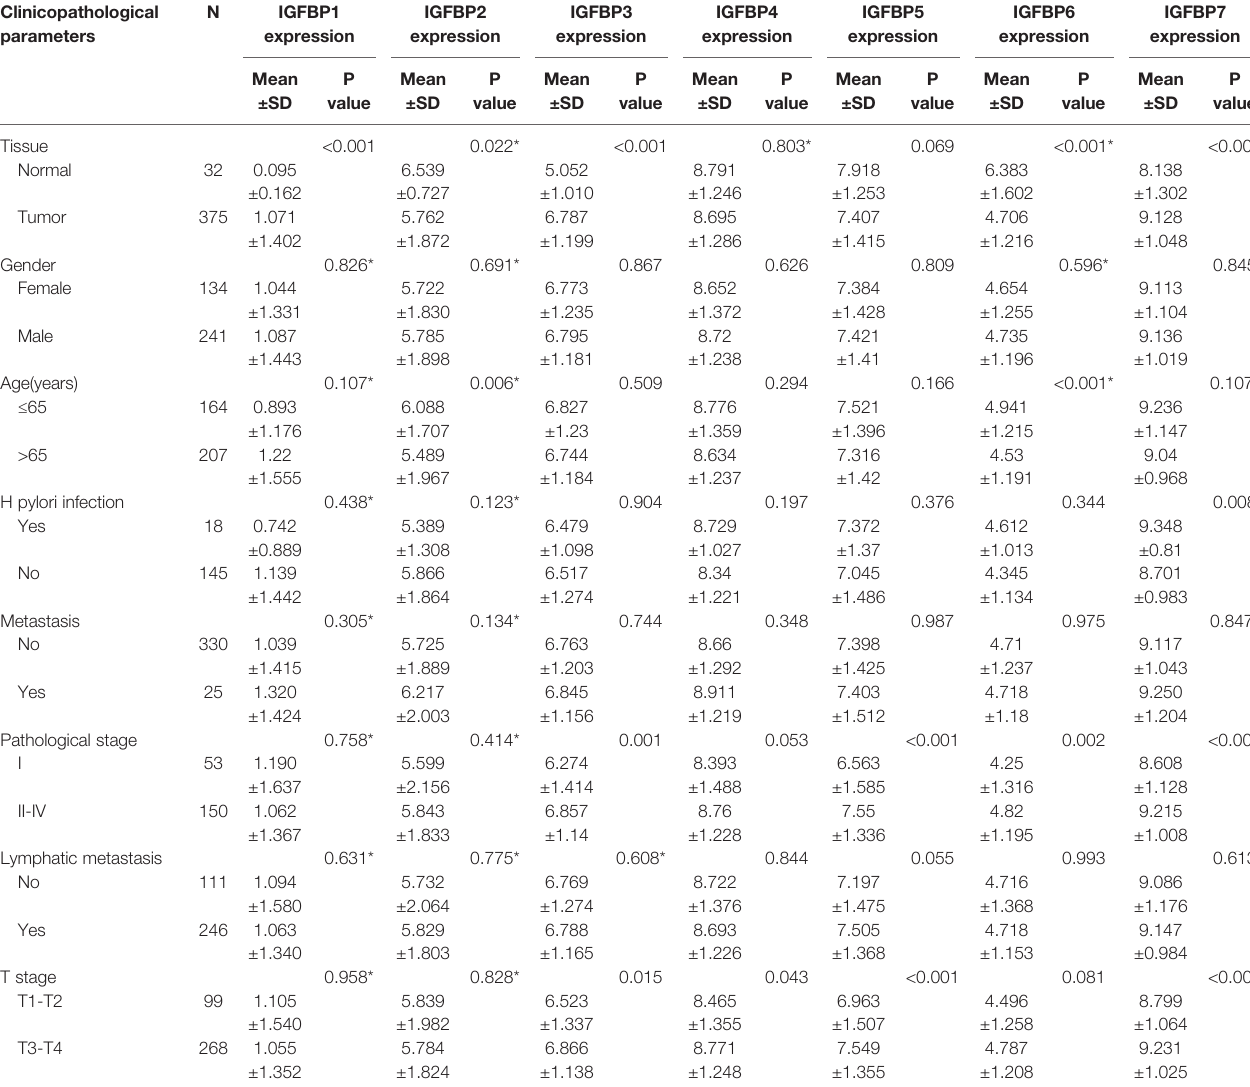
TABLE 2 | The relationships between IGFBP1/3/5/7 with clinicopathological parameters in STAD